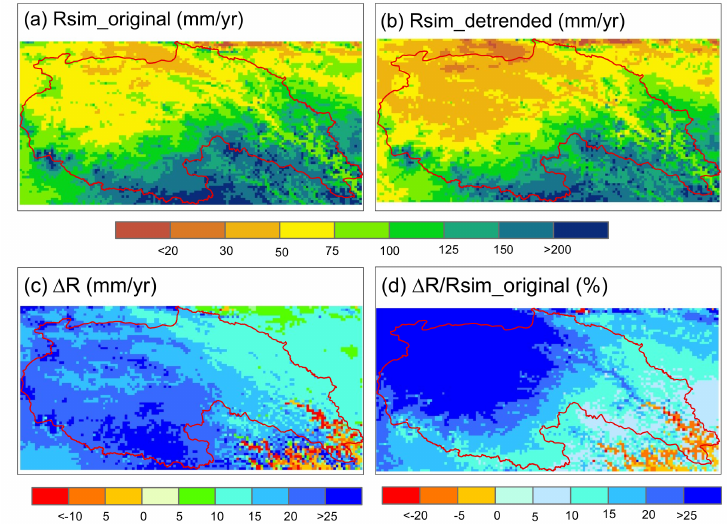
Figure 8. Comparison of simulated runo ff across the study basin using the original (Rsim_original) and detrended (Rsim_detrended) forcing variables ( a , b ). Here, the detrending was performed for all the forcing variables used in the abcd-snow model. ( c ) the di ff erence in the mean annual runo ff simulations obtained from the original and detrended forcing variables ( ∆ R). ( d ) ∆ R as the percentage of Rsim_original across the study basin ( ∆ R /